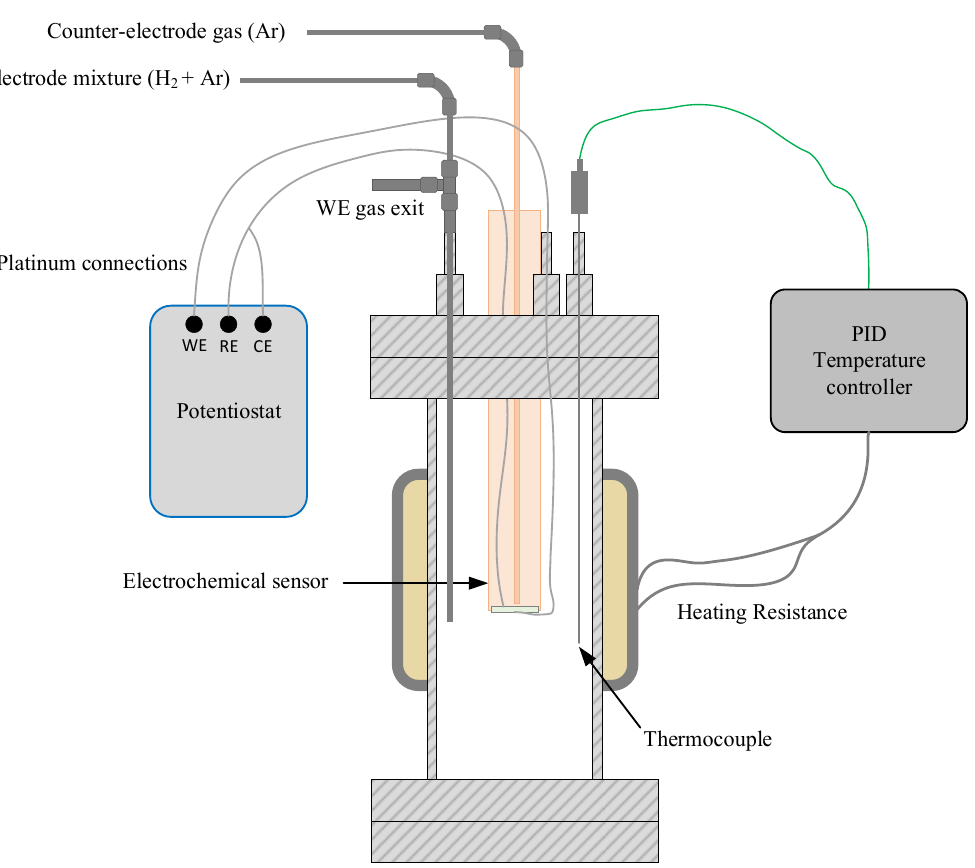
Figure 2. Representation of the reactor where the electrochemical measurements were performed, showing connections to external systems (WE: Working electrode, RE: Reference Electrode, CE: Counter-electrode).